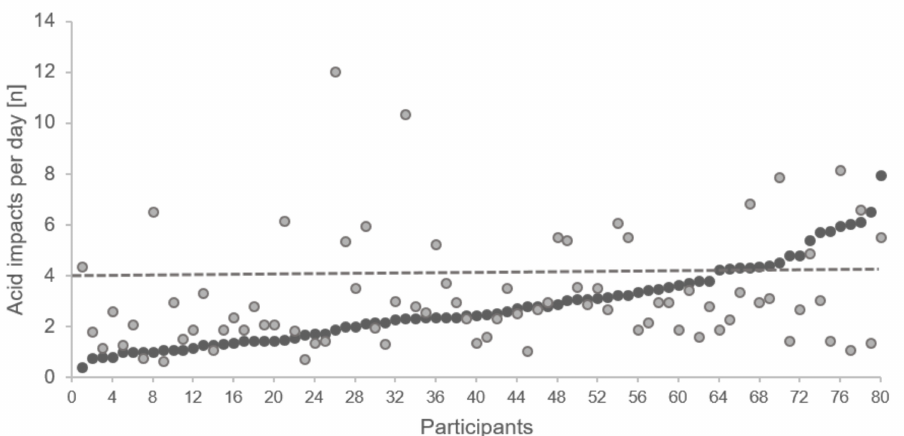
Figure 2. Scatterplot of acid impacts per day at T0 and T1, participants were ranked by their acid impacts at T0. The dotted line indicates the threshold for low and high acid impact groups; black dots indicate the number of acid impacts per day at T0 and the grey dots the corresponding values at